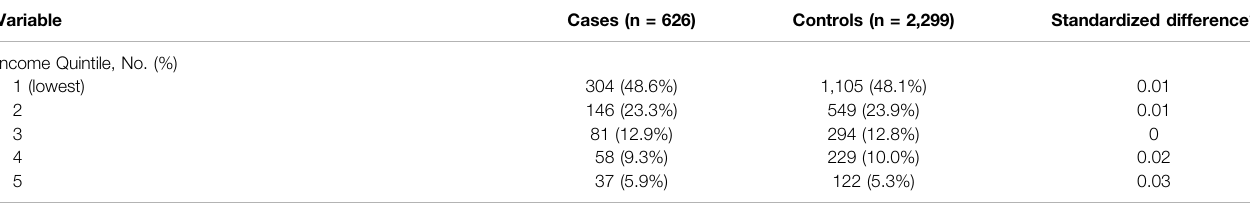
TABLE 2 | Association between sudden death or ventricular dysrhythmia and recent serotonin reuptake inhibitor use. Serotonin Reuptake Inhibitor (SRI) Exposure in